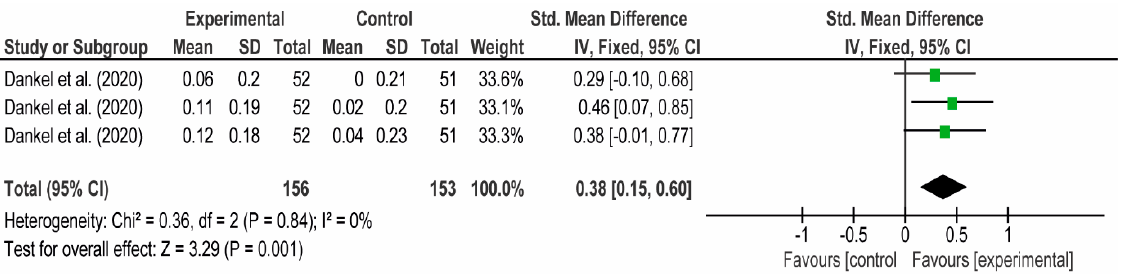
Figure 22. The effect size of 6 -weeks of heavy elbow flexion exercise on the elbow flexors’ MT. The lines respectively represent 50%, 60% and 70% measurement levels of elbow flexors’ MT.